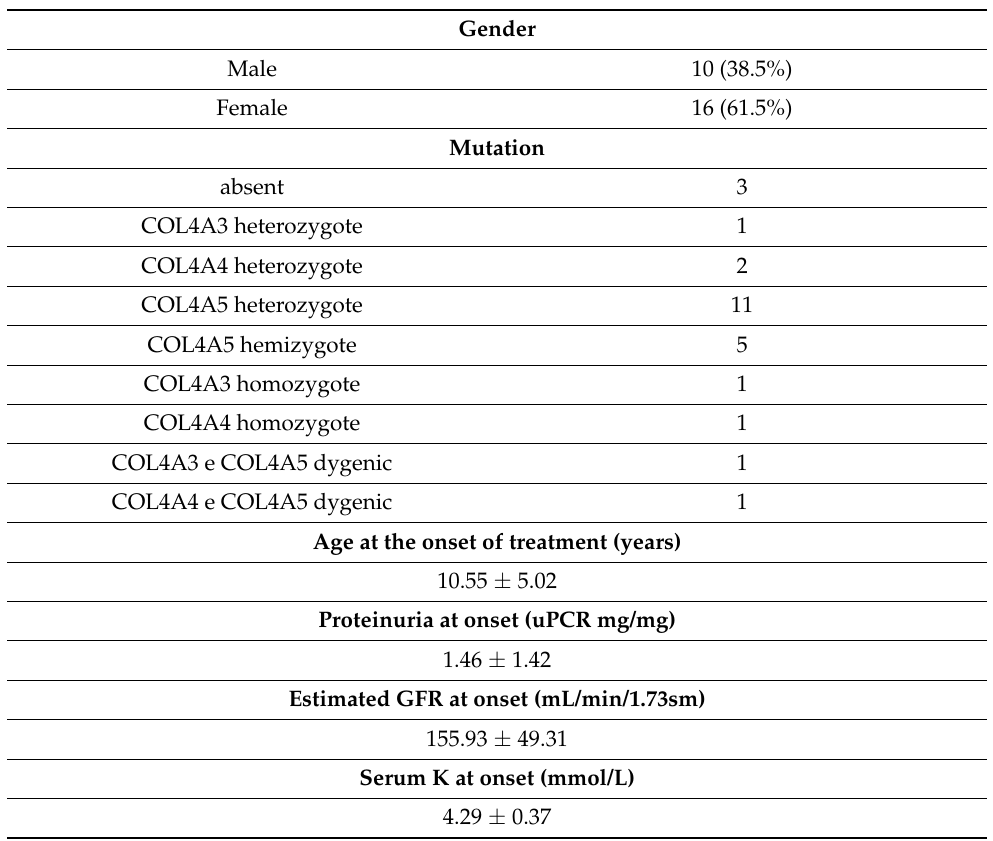
Table 1. Demographic and clinical data of patients at baseline. Proteinuria and creatinine clearance levels are presented as mean ± standard deviation (SD).